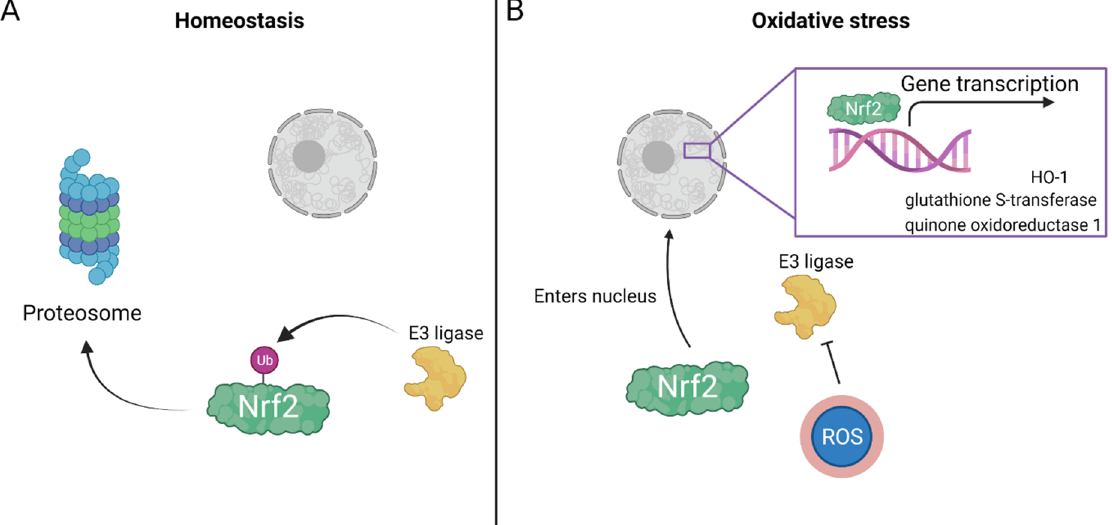
Figure 3. Nrf2 enters the nucleus under oxidative stress conditions. ( A ) At basal conditions, the E3 ligase targets Nrf2 for ubiquitination and marks it to be sent to the proteosome for degradation. Thus, Nrf2 does not enter the nucleus. Under oxidative stress conditions, free radicals can attach to the E3 ligase creating a conformational change that inhibits its binding to Nrf2 and, by this, allows Nrf2 to enter the nucleus. ( B ) In the nucleus, Nrf2 initiates gene transcription of protective genes, such as the antioxidants HO-1, glutathione S-transferase, quinone oxidoreductase 1.